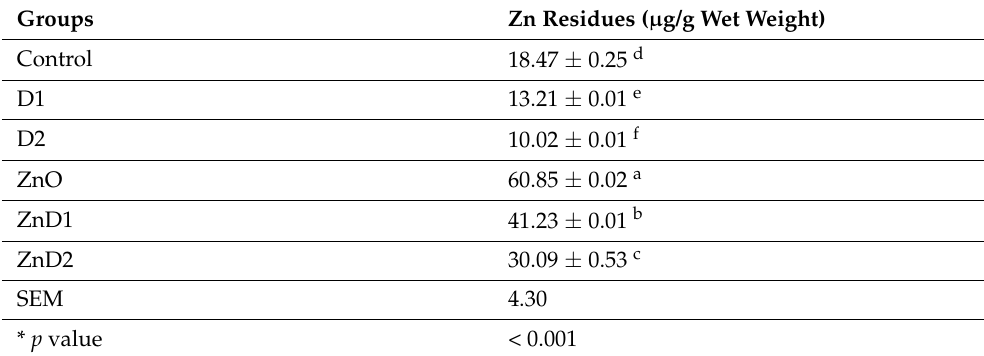
Table 3. Effects of D. salina on the Zn residues accumulation ( µ g/gm wet weight) in the whole body of the treated male zebrafish (Means ±